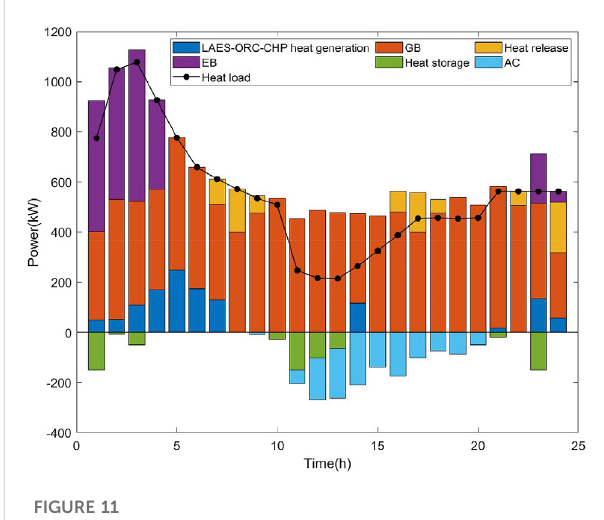
FIGURE 11 Heat power balance of scenario